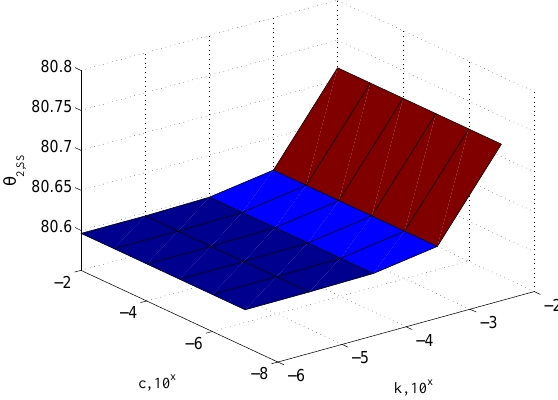
Figure 9. Dependency of the steady state angle θ 2, ss on k .